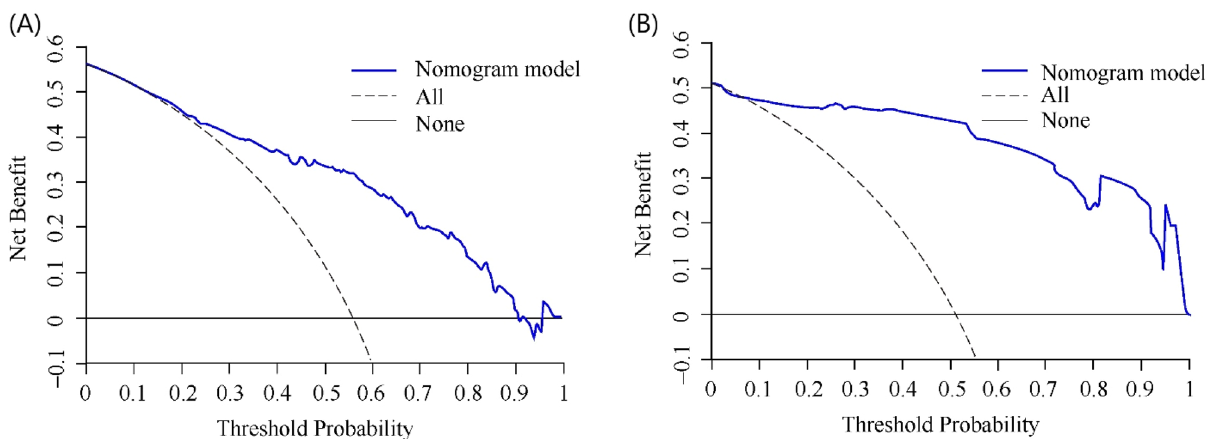
Figure 3. Figure shows the results of the decision curve analysis for the nomogram model. ( A ) The decision curve of the training cohort, and ( B ) is the verification cohort. The clinical utility of the nomogram prediction model was greater when the threshold probability was between 0.44 and 0.68 or greater than 0.78.